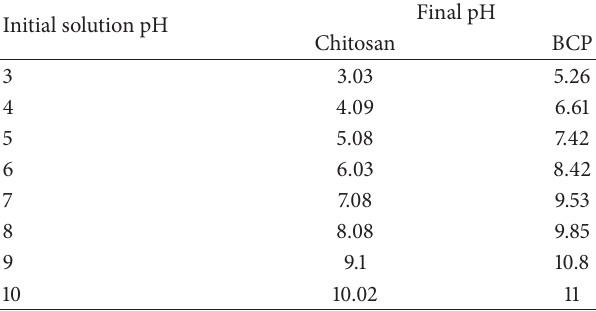
Table 3: Variation of solution pH during OII removal by chitosan and BCP (OII concentration 200 mg/L, reaction time 10 min, and BCP and chitosan dose